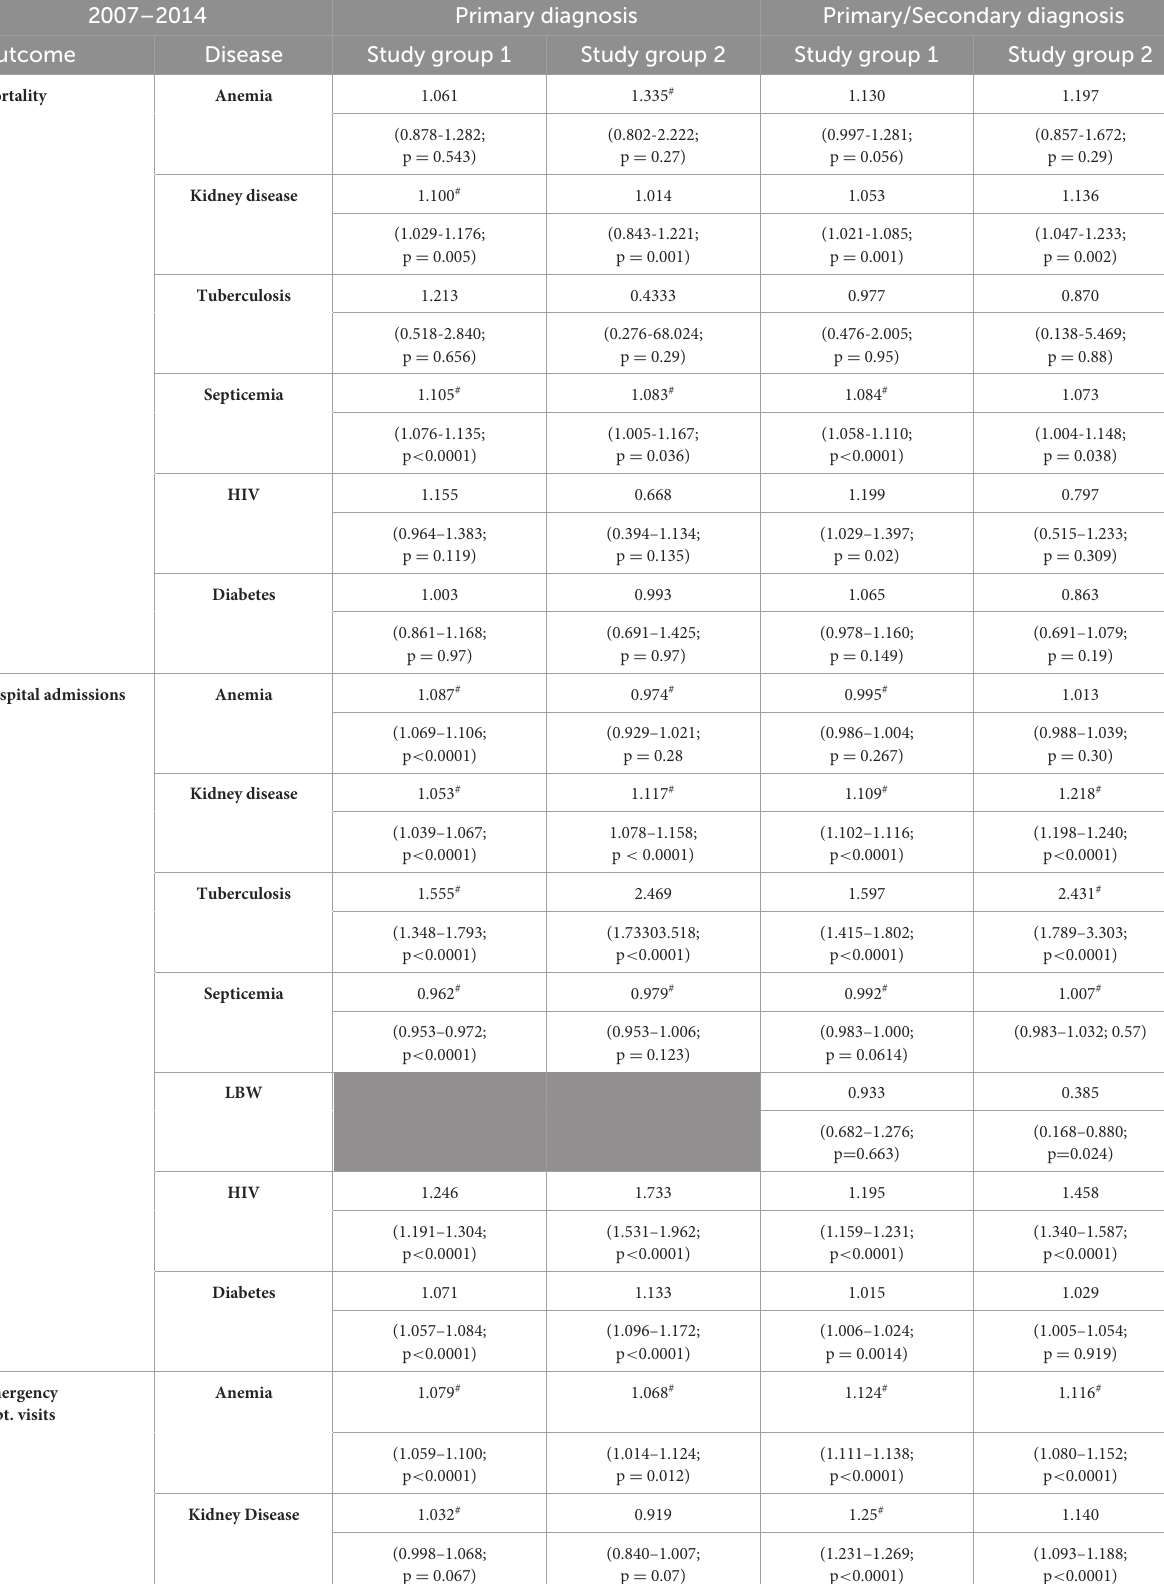
TABLE 1 Results of the logistic regression